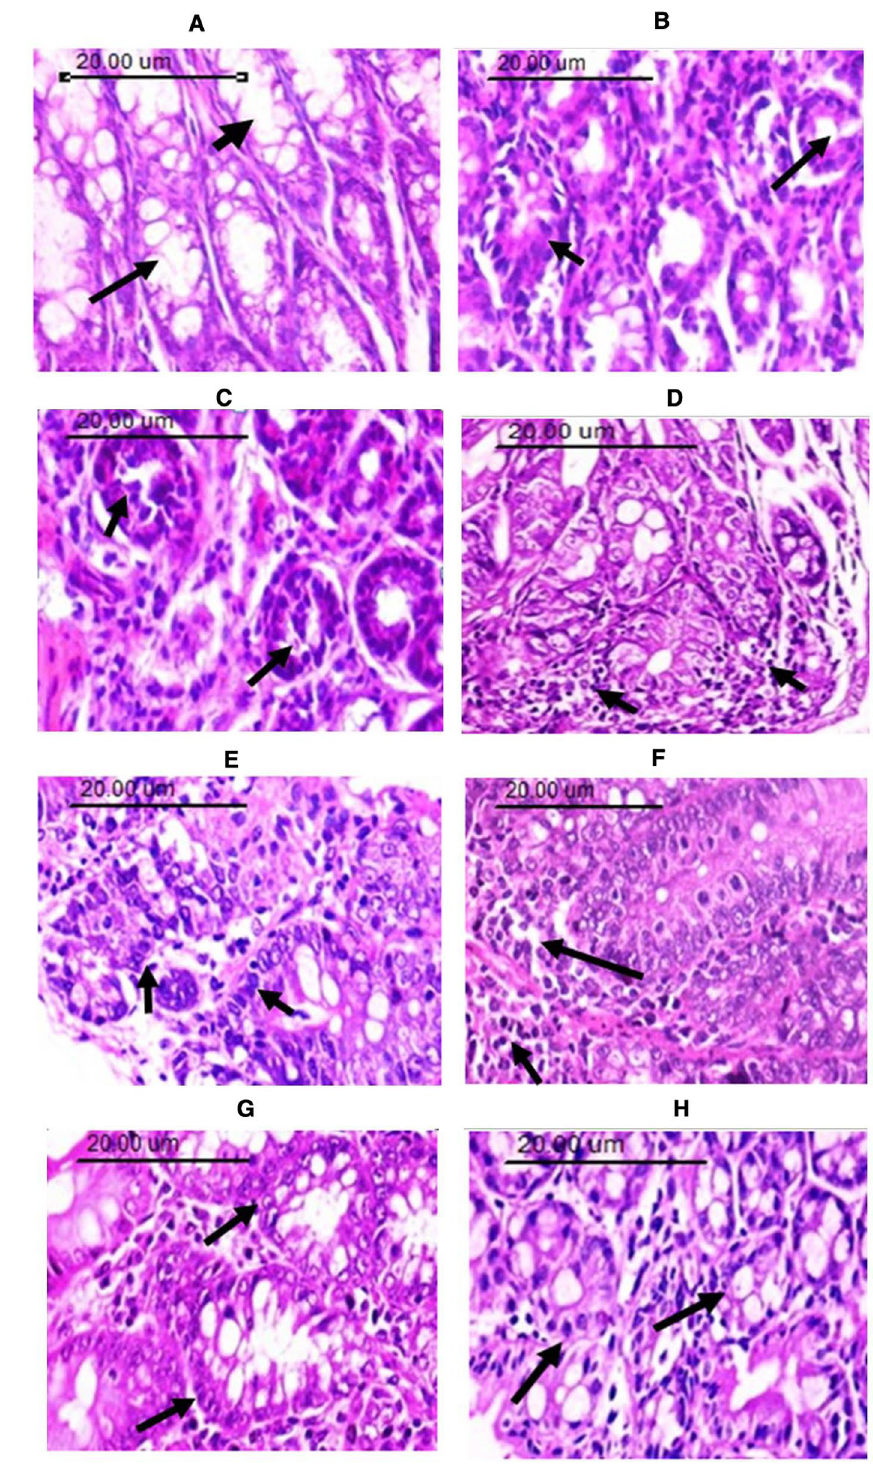
Fig. 10 Photomicrographs of mouse colon sections stained with hematoxylin and eosin showing A Normal control, the arrow refers to intestinal glands lined by high cuboidal epithelial cells with numer- ous numbers of goblet cells, B , C Dysplasia of the mucosal lining epithelium as well as glandular structure with lose of goblet cells formation, pleomorphism in the cells as well as hyperchromatic nuclei of DMH treated animals. The arrow in (B) indicates crowded glands with irregularity in shape and size, and in C indicates intestinal glands with elongated nuclei, loss of cell polarity, increased mitotic activity and lack of goblet cells D Dysplasia in lining glandular mucosal epithelium with goblet cells formation in the thiophene derivative treated group. The arrow refers to few numbers of goblet cells with decreased number of inflammatory cells E Dysplasia of the mucosal lining epithelium with pleomorphic nuclei (arrow) with goblet cells formation in the γ-irradiated group. F Massive inflammatory cells permeation in the lamina propria of the mucosa, muscu- laris mucosa and submucosa (arrow) in colon from cisplatin treated group. G Mild degree of dysplastic changes and well differentiated intestinal glands (arrow) in DMH + T + R group. H Moderate degree glandular epithelia dysplasia and more crowded glands (arrow) in DMH + cis + R